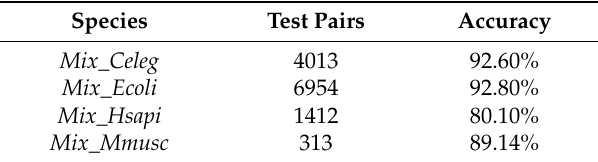
Table 5. Prediction results of the proposed method on four other species.